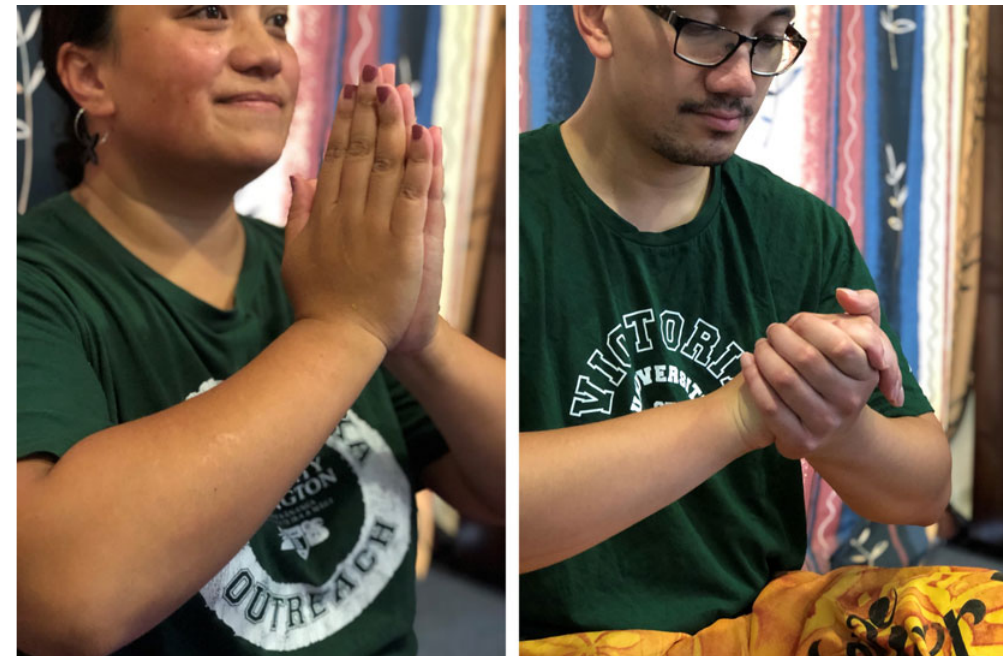
Fig. 1. Pati (clap) and P ō (hollow clap from cupped hands).